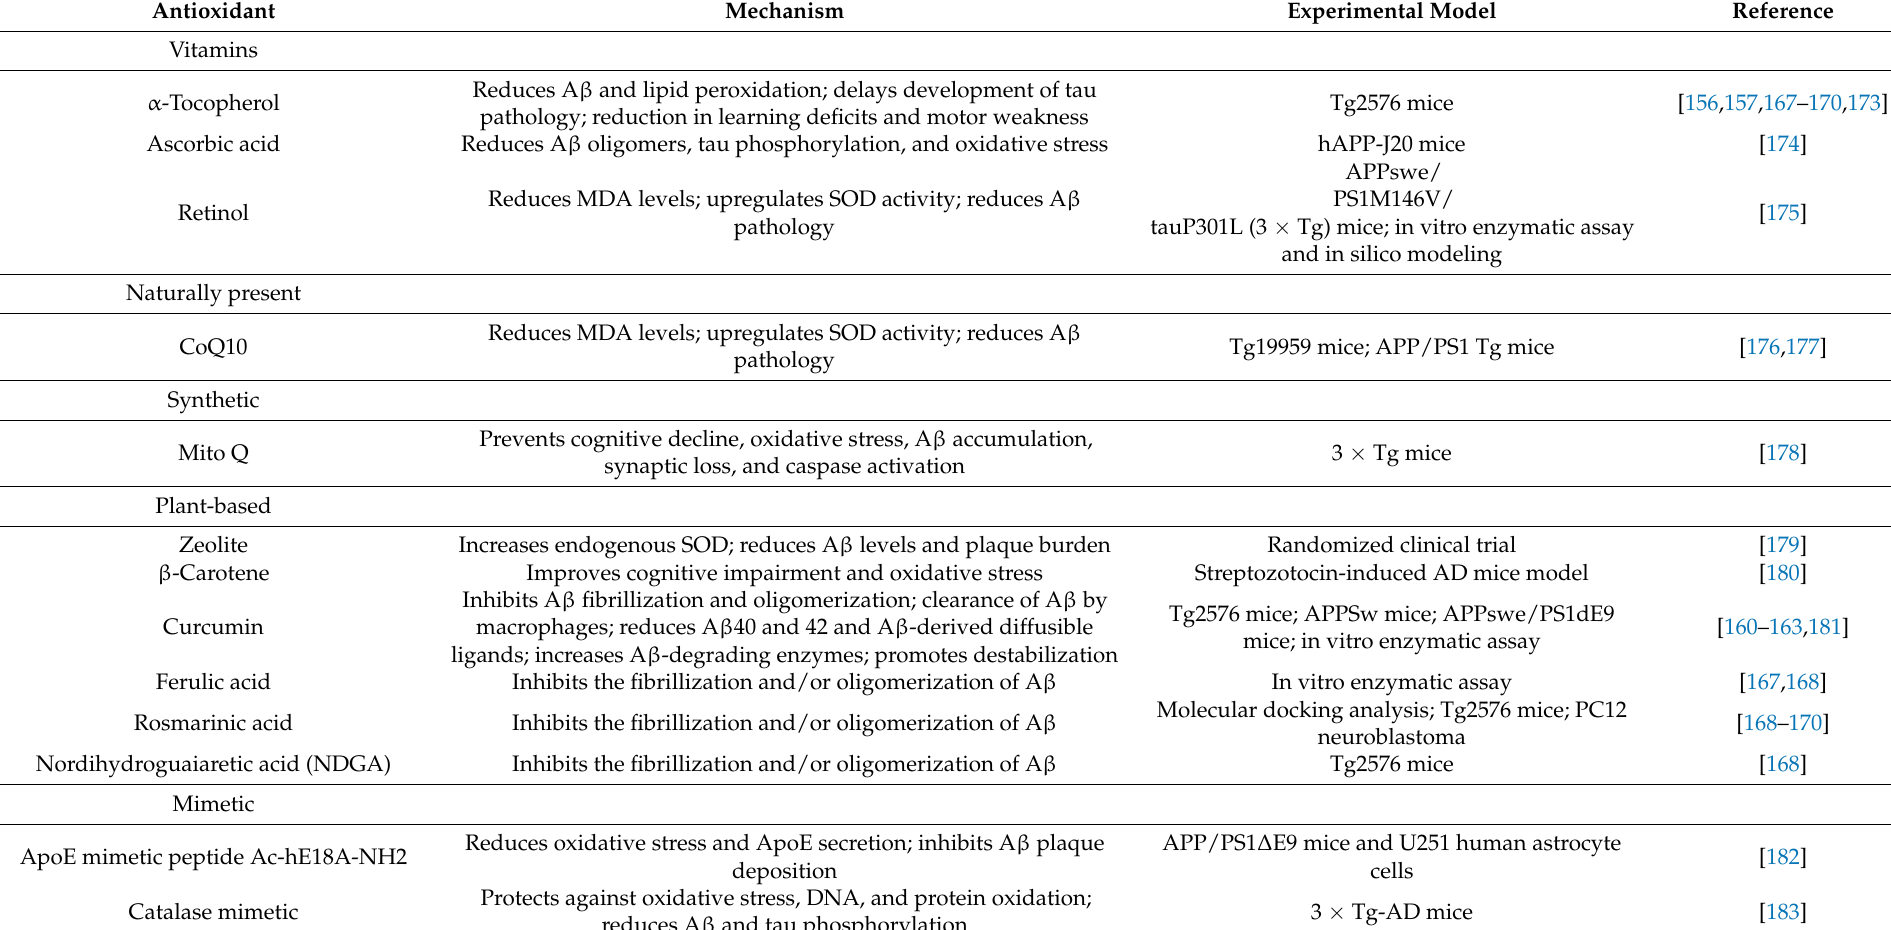
Table 1. Overview of the experimentally documented roles of various known natural antioxidant compounds in cases of Alzheimer’s